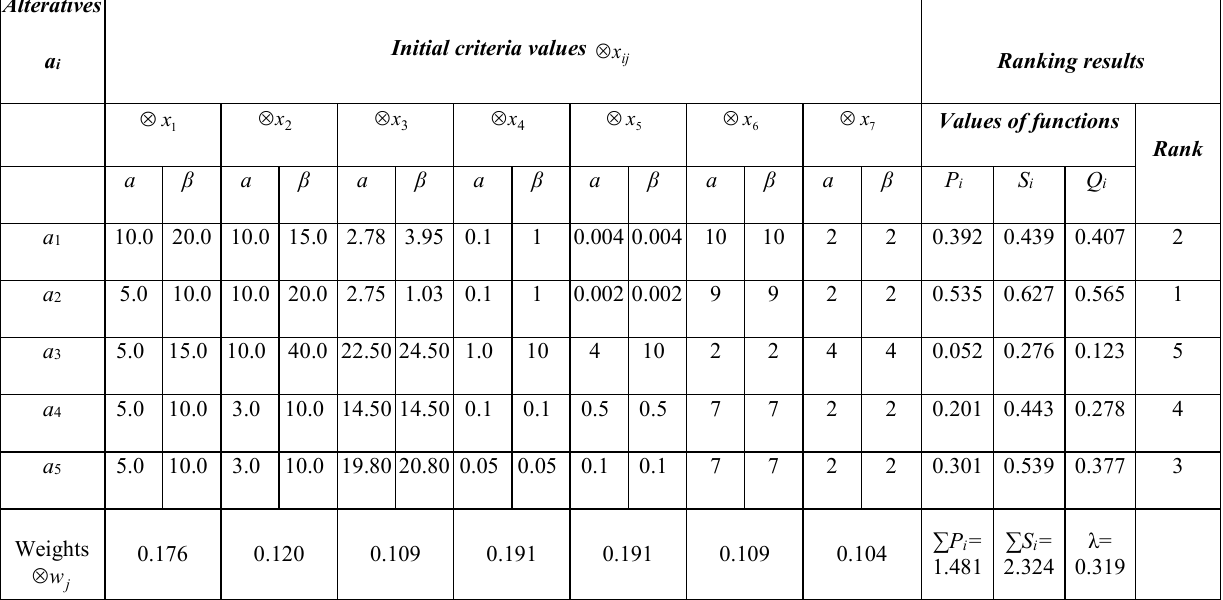
Table 1. Initial decision-making matrix and rankings in terms of